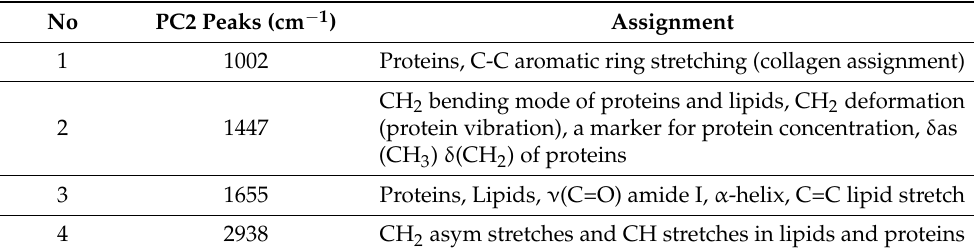
Table 2. Major Raman peaks found in PC1 between BR1 and BR2 analysis.